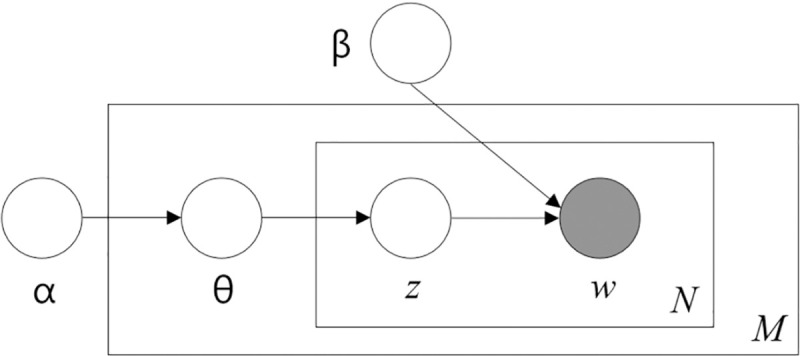
Graphical model representation of LDA.(Source: [13]).